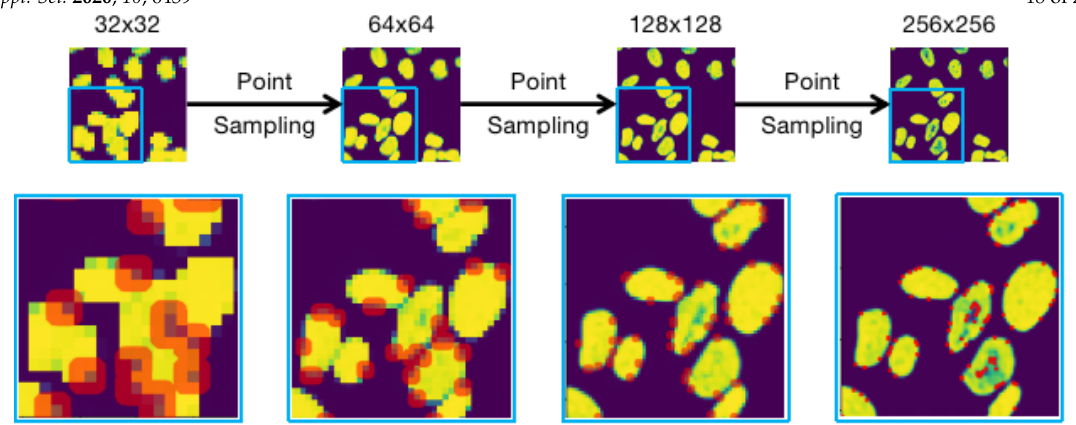
Figure 15. Diagram of the Point-sampling process for rendering a higher resolution boundary when inferring nuclei. The red dots in different resolution are the selected uncertain points to calculate.